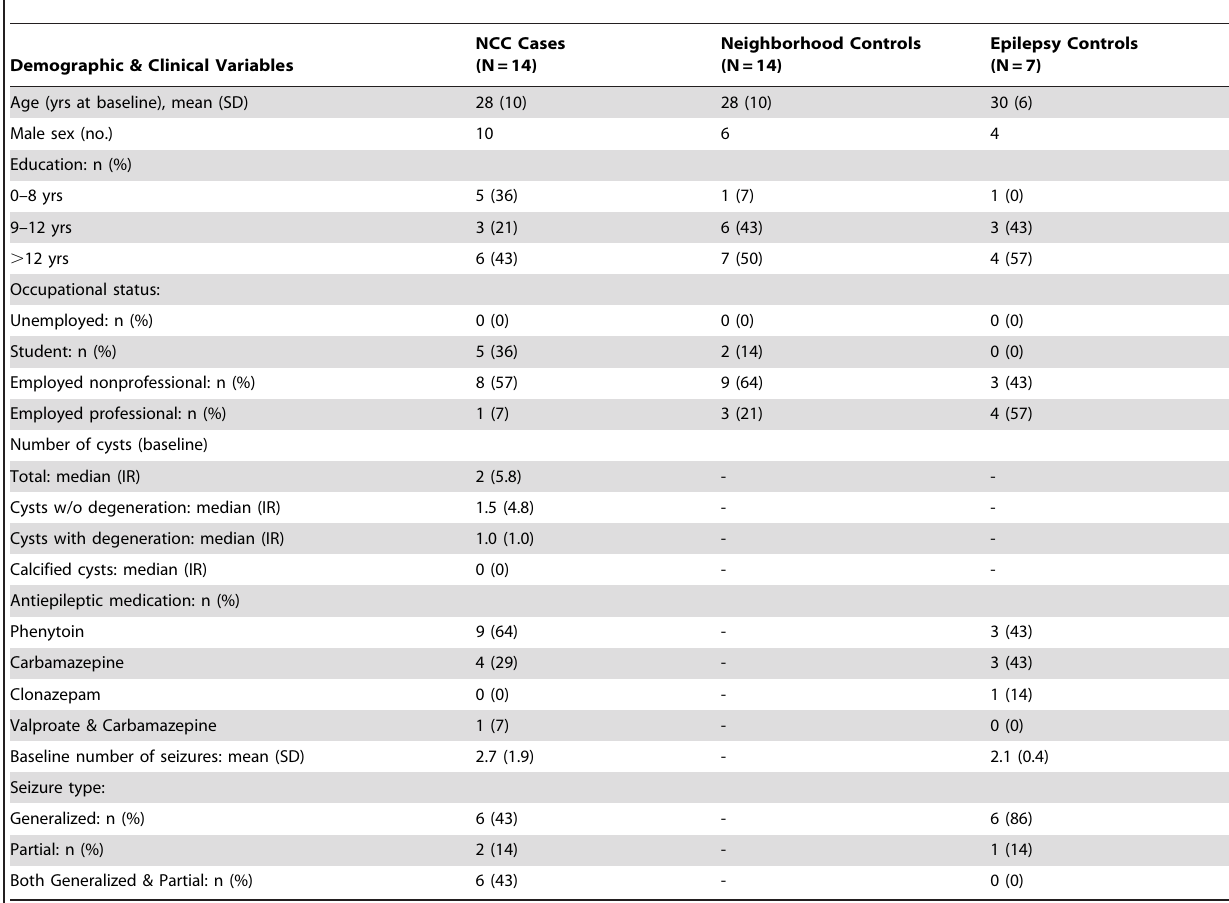
Table 2. Demographic and clinical summary of neurocysticercosis cases and controls.